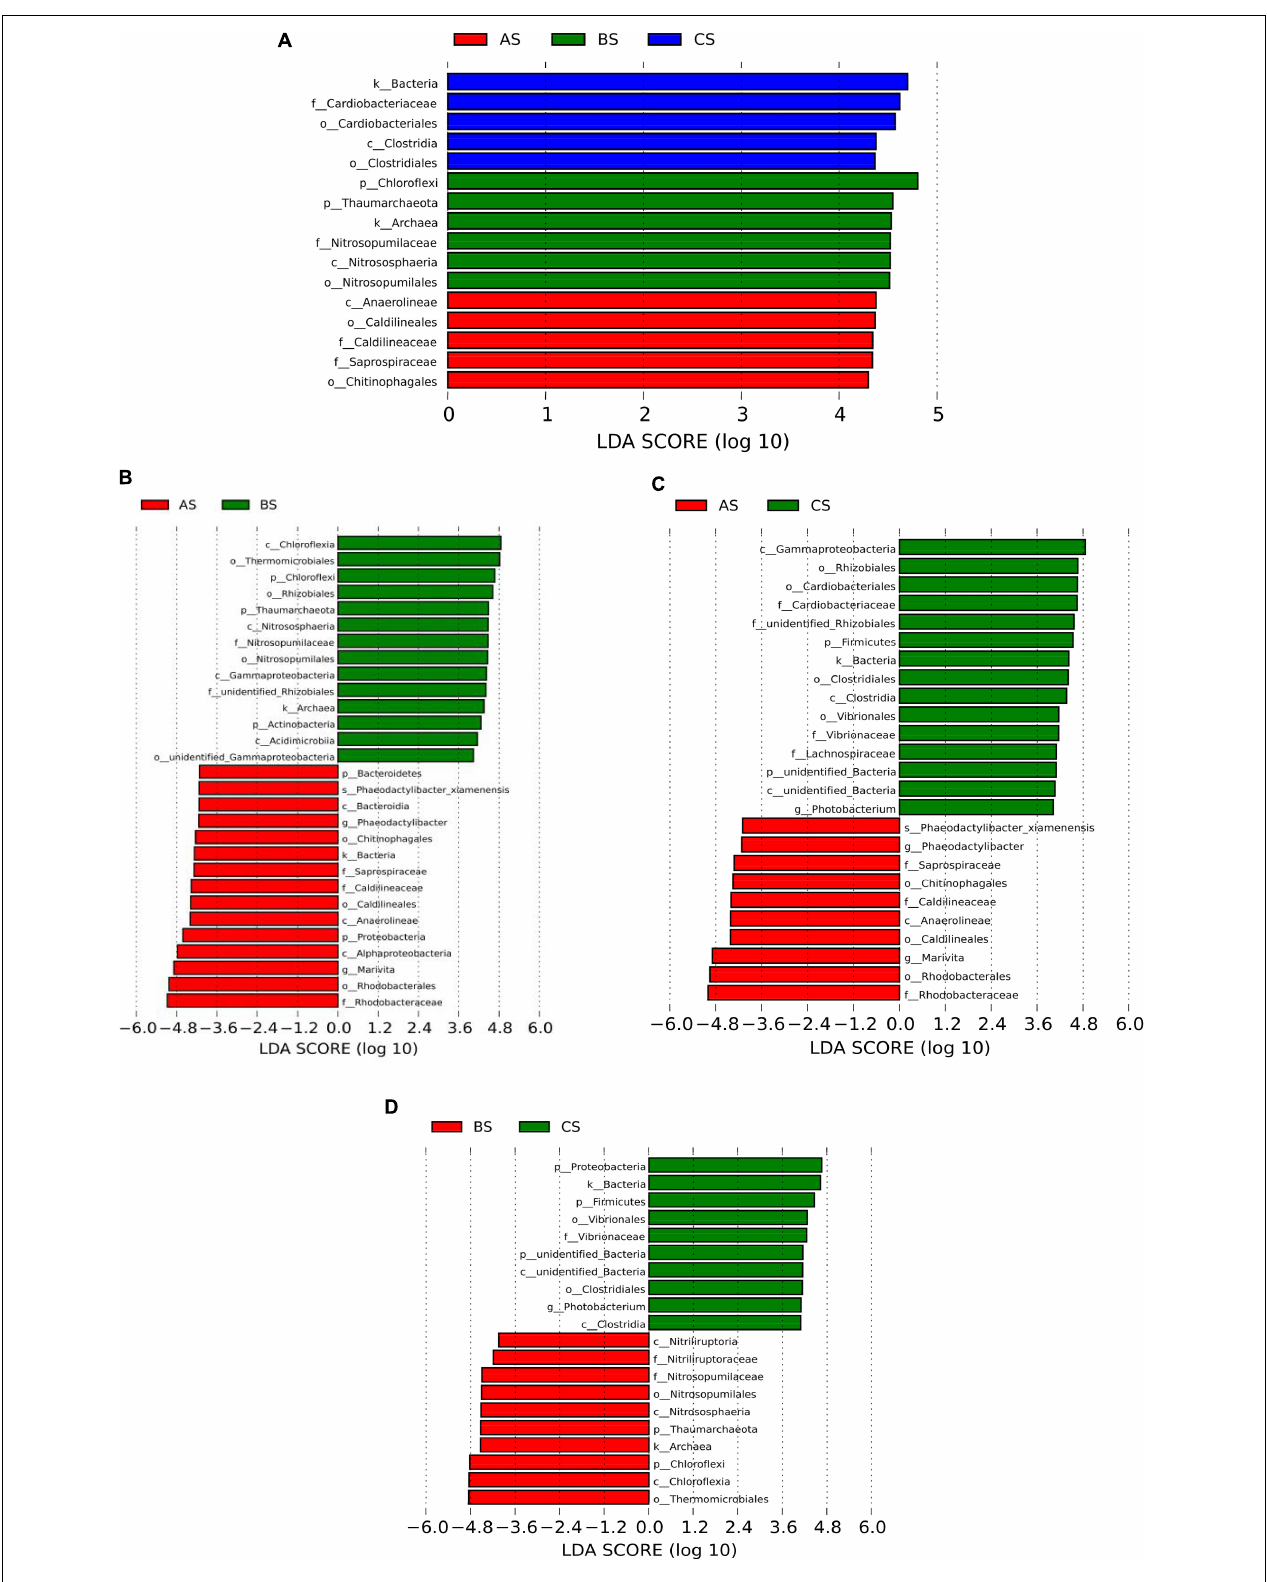
FIGURE 2 | LEfSe analysis among AS vs. BS vs. CS (A) , AS vs. BS (B) , AS vs. CS (C) , BS vs. CS (D) . Only taxa with a LDA value higher than 4 are shown. AS, water sample; BS, biofloc sample; CS, intestinal sample.